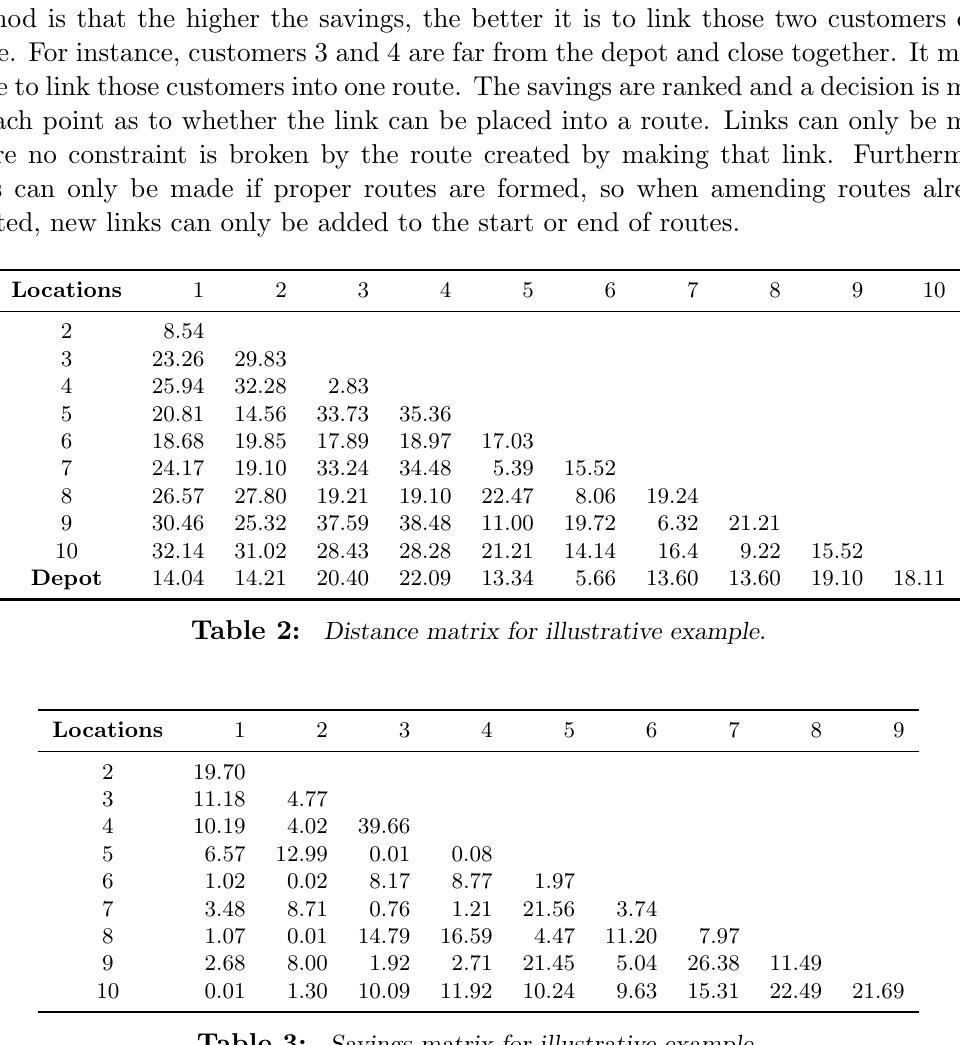
Table 3: Savings matrix for illustrative